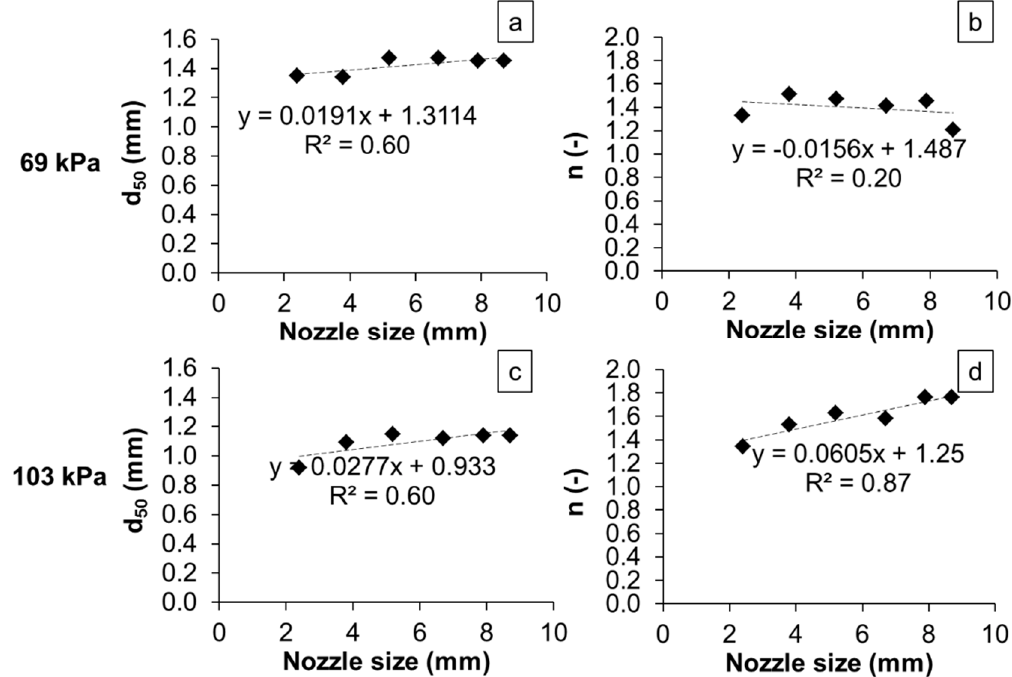
Figure 8. Optimal parameters of Weibull drop size distribution model ( d 50 and n ) for both operating pressures 69 kPa ( a , b ) and 103 kPa ( c , d ). The dashed line represents the linear regression for each case.